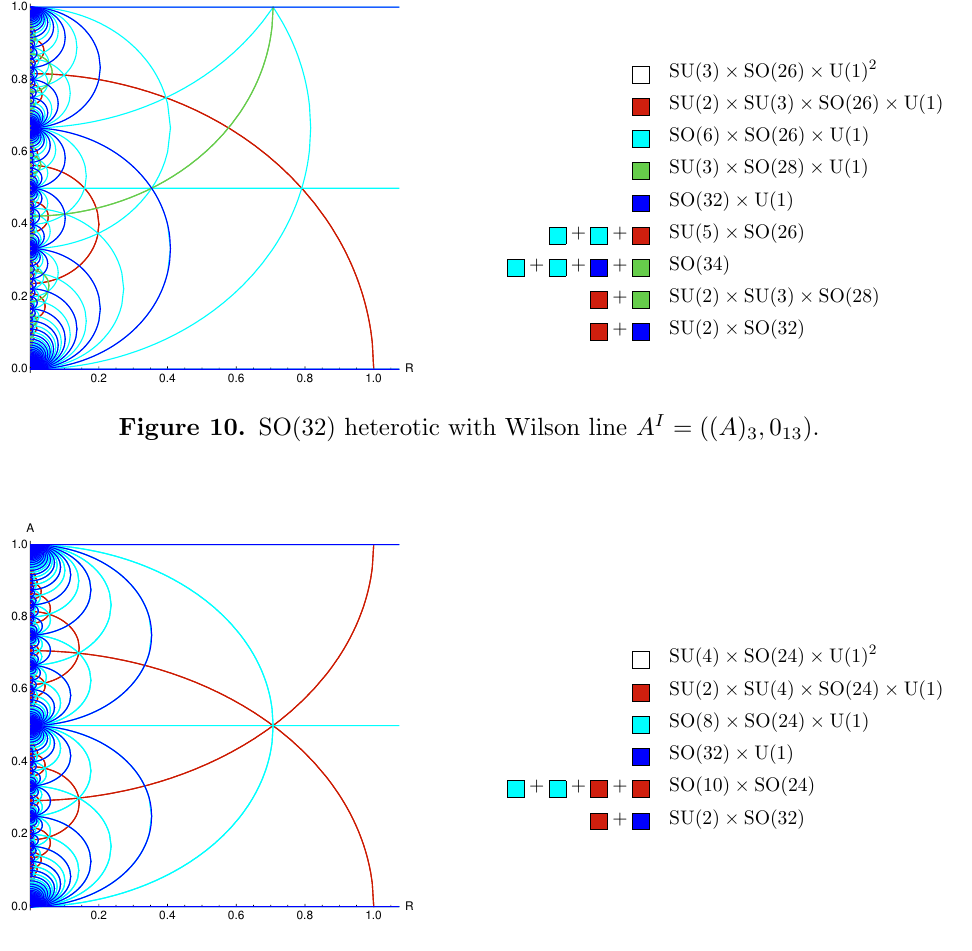
Figure 11. SO(32) heterotic with Wilson line A I = (( A ) 4 ; 0 12 ).